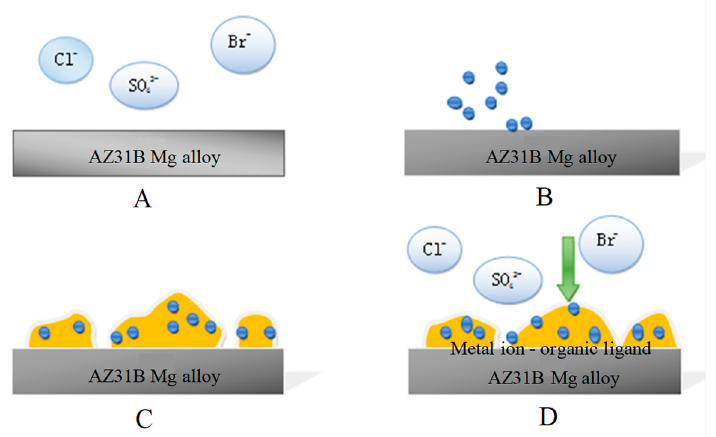
Figure 9. Corrosion effect of B. subtilis biofilm on the AZ31B magnesium alloy surface. ( A ) Substrate material; ( B ) Cells adhesion; ( C ) Thin biofilm; ( D ) Dense biofilm.